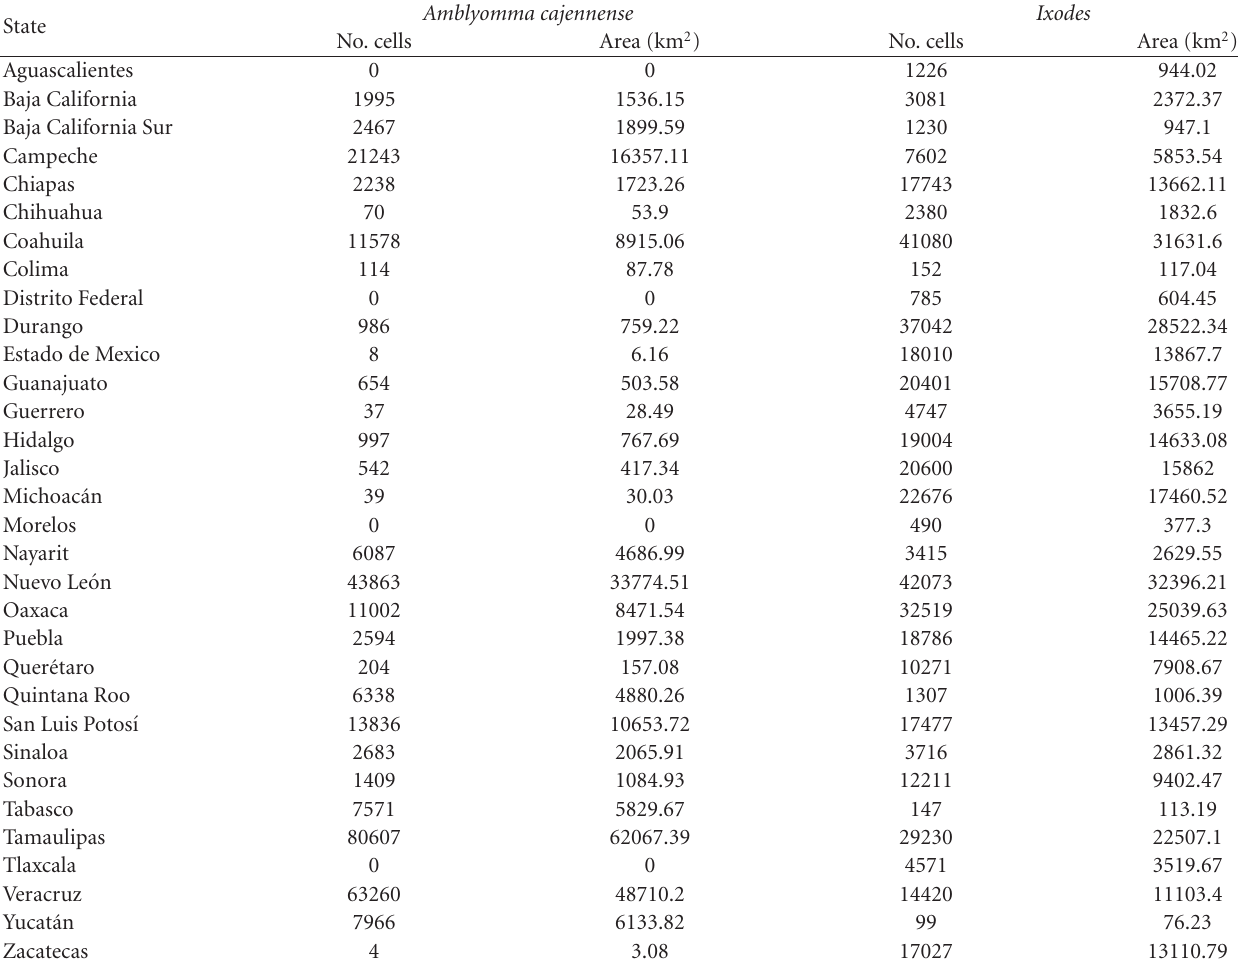
Table 3: Size (area) of predicted range of Amblyomma cajennense and the Ixodes